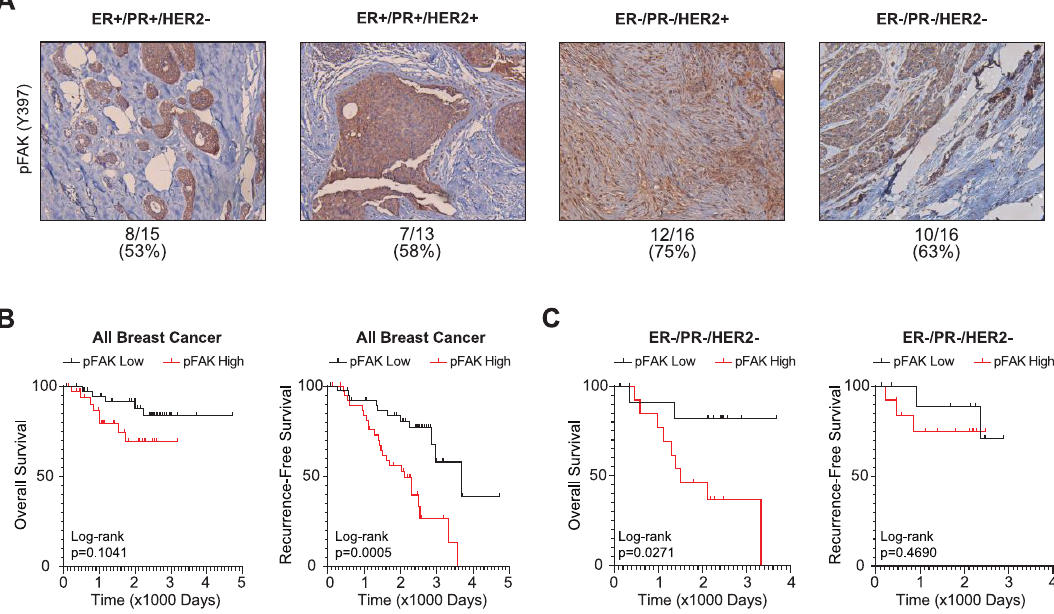
Figure 3. FAK activation is associated with worse breast cancer patient outcomes. ( A ) Representative images (10 × ) of 60 primary breast cancer tissue cohorts grouped by subtype. Tissues were stained for phosphorylated FAK on tyrosine residue 397 (pFAK Y397). ER, estrogen receptor. PR, progesterone receptor. HER2, human epidermal growth factor receptor 2. Below: Calculated percentage of positively stained tumors. ( B ) Overall and recurrence-free survival outcomes of stained tissue microarray for pFAK Y397 in all breast cancer subtypes. The top 30% of patients with high pFAK Y397 ( n = 40) were compared to the bottom 30% of patients with low pFAK Y397 ( n = 40). Log-rank test where p < 0.05 is statistically significant. ( C ) Overall and recurrence-free survival in TNBC patients comparing the top 30% with high pFAK Y397 ( n = 13) to the bottom 30% with low pFAK Y397 ( n =